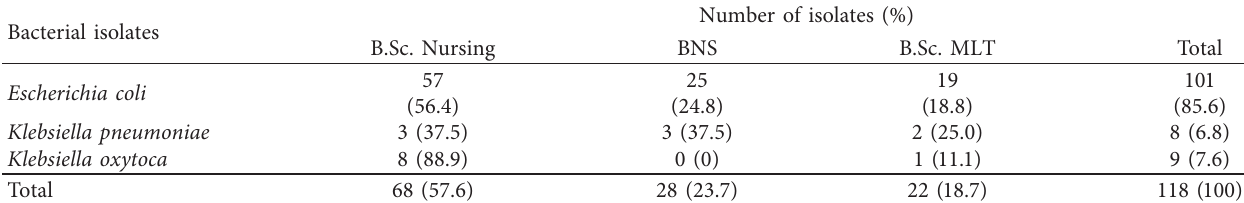
Table 2: Distribution of E. coli and Klebsiella species among different programs of HS students.